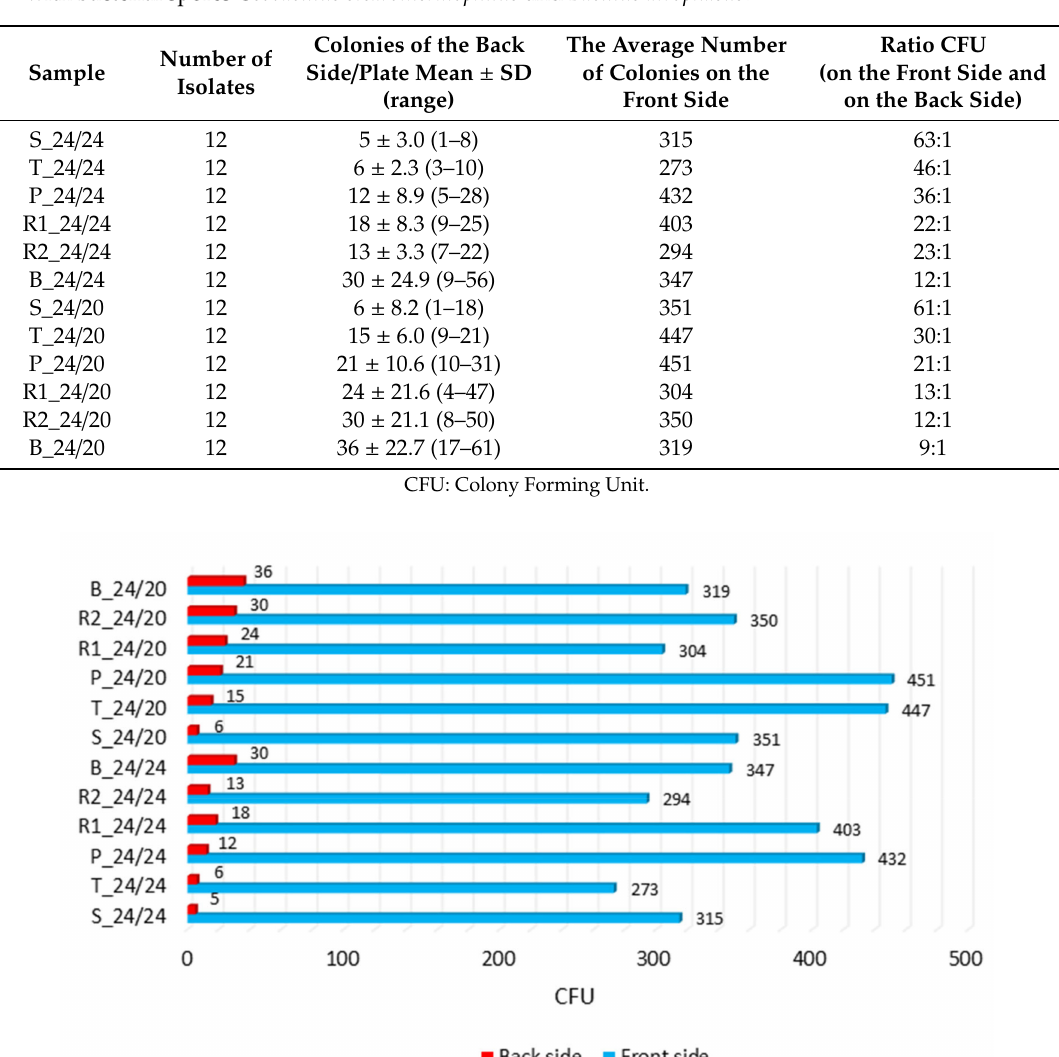
Table 6. Results of microbial barrier permeability for the tested textiles after extreme contamination with bacterial spores Geobacillus stearothermophilus and Bacillus atrophaeus .